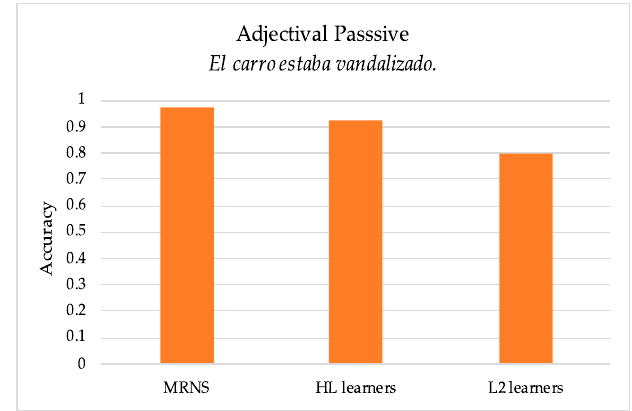
Figure 5. PMT: Mean accuracy on adjectival and verbal passives.